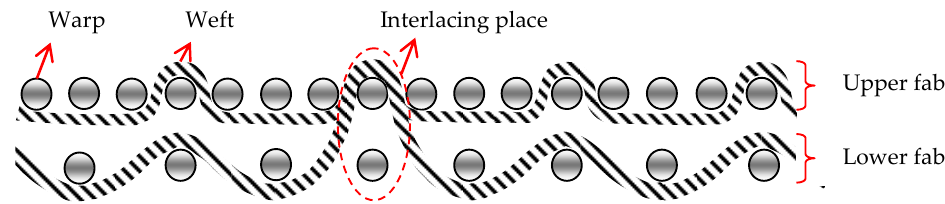
Figure 2. Cross-section of 3D fabric marked “tp”.